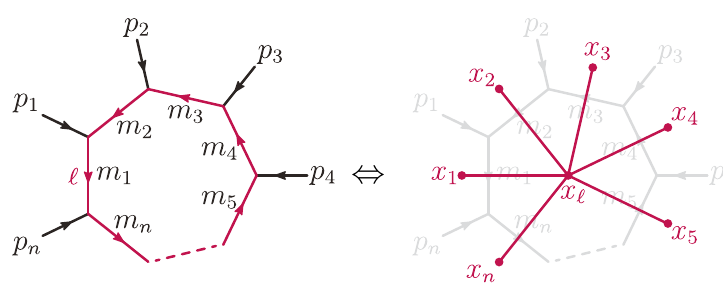
Figure 1 . The n -point, all-mass integral and its dual-momentum space